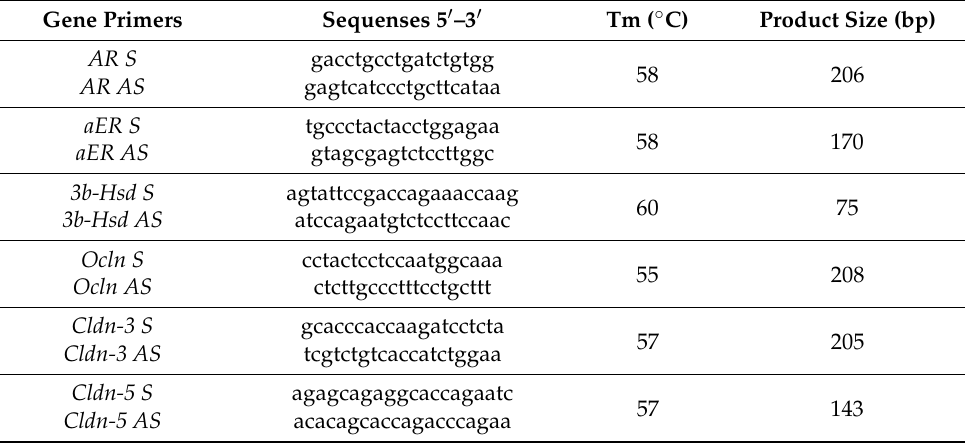
Table 1. Primer sequences (S: sense; AS: antisense), annealing temperature (Tm) and product size (bp) used for testicular gene expression analyses in CTRL and BPA exposed mice by Real-Time qPCR. Gene